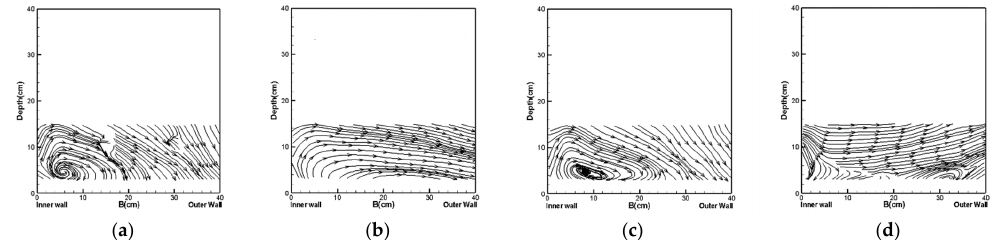
Figure 8. The latitudinal distribution of velocity at 45 degrees with and without a W − Weir, ( a ) Fr = 0.17 with a W − Weir, ( b ) Fr = 0.17 without a W − Weir, ( c ) Fr = 0.28 with a W − Weir, and ( d ) Fr = 0.28 without a W − Weir.